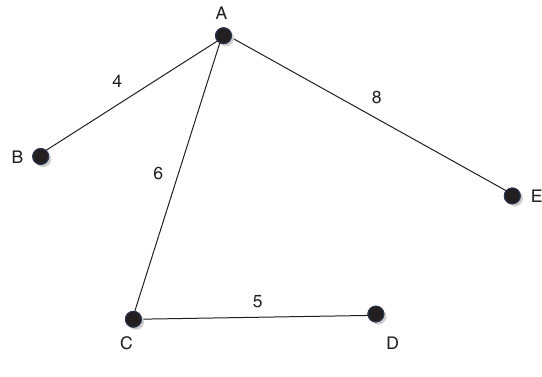
Figure 2. Spanning